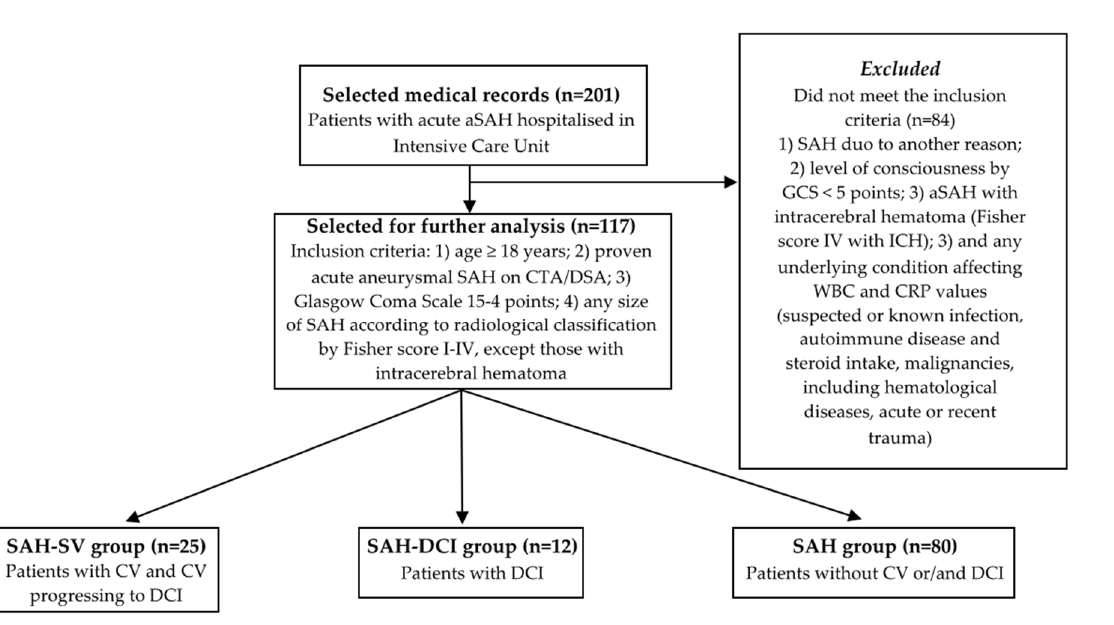
Figure 1. Patient selection flow chart. aSAH—aneurysmal subarachnoid hemorrhage; CTA—computer tomography angiography; DSA—digital subtraction angiography; GCS—Glasgow Coma Scale; CV—cerebral vasospasm; DCI—delayed cerebral ischemia.